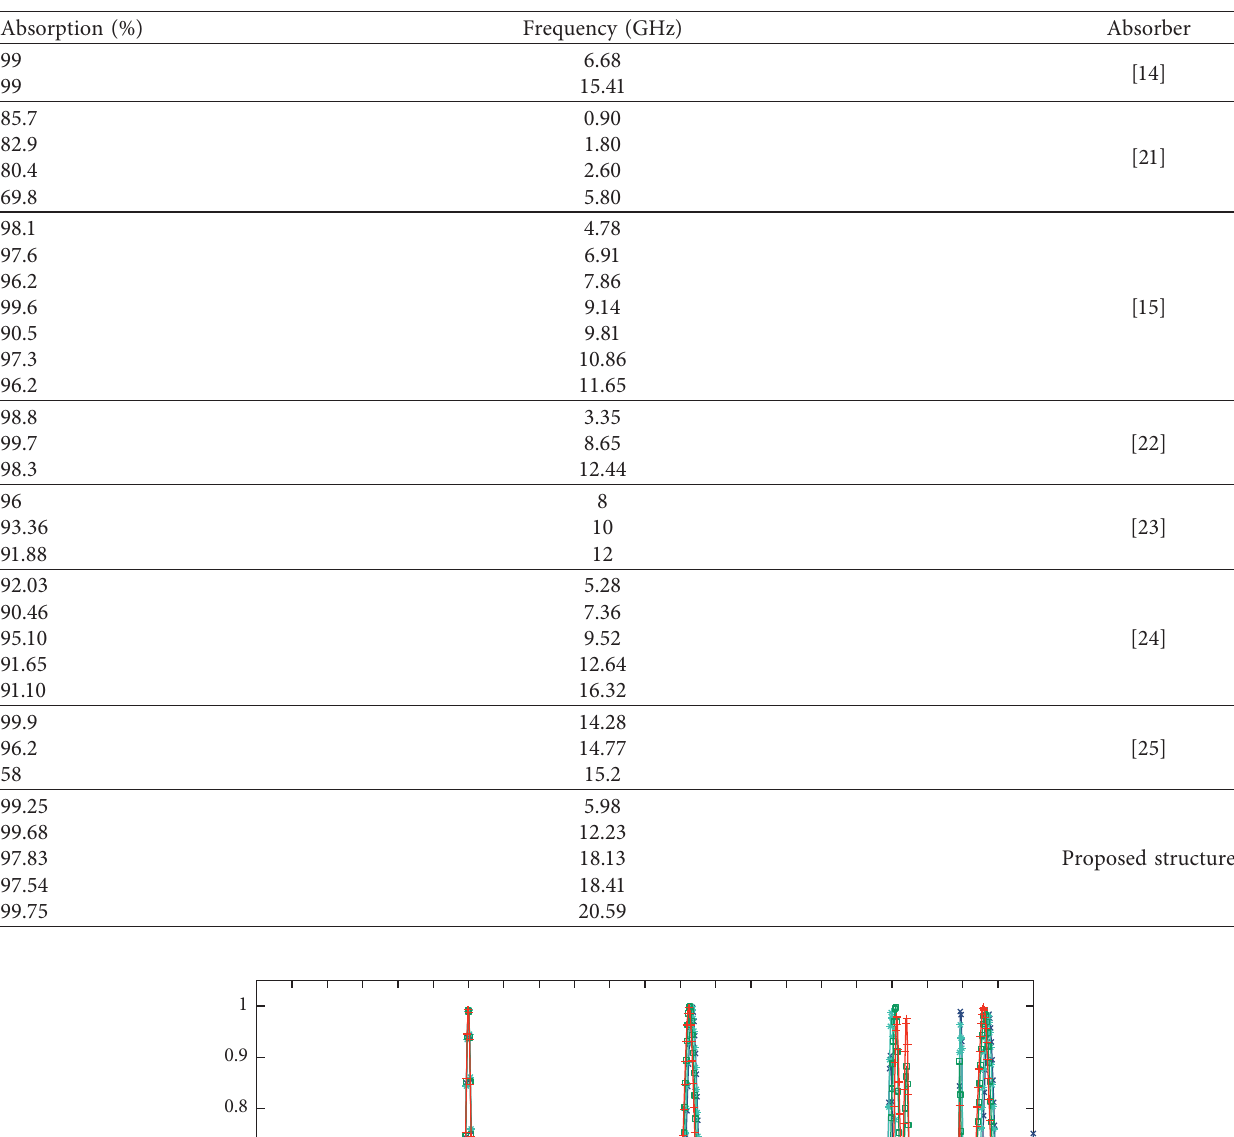
Table 2: Multiband MMA.